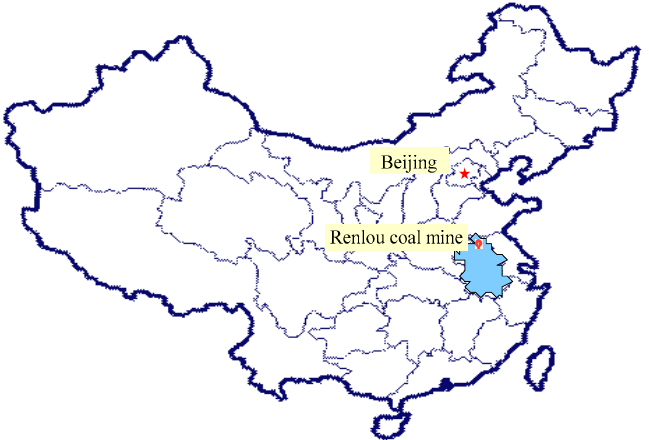
Figure 10. Renlou coal mine II 7 2 24N coal face (Huaibei, Anhui, PR China).